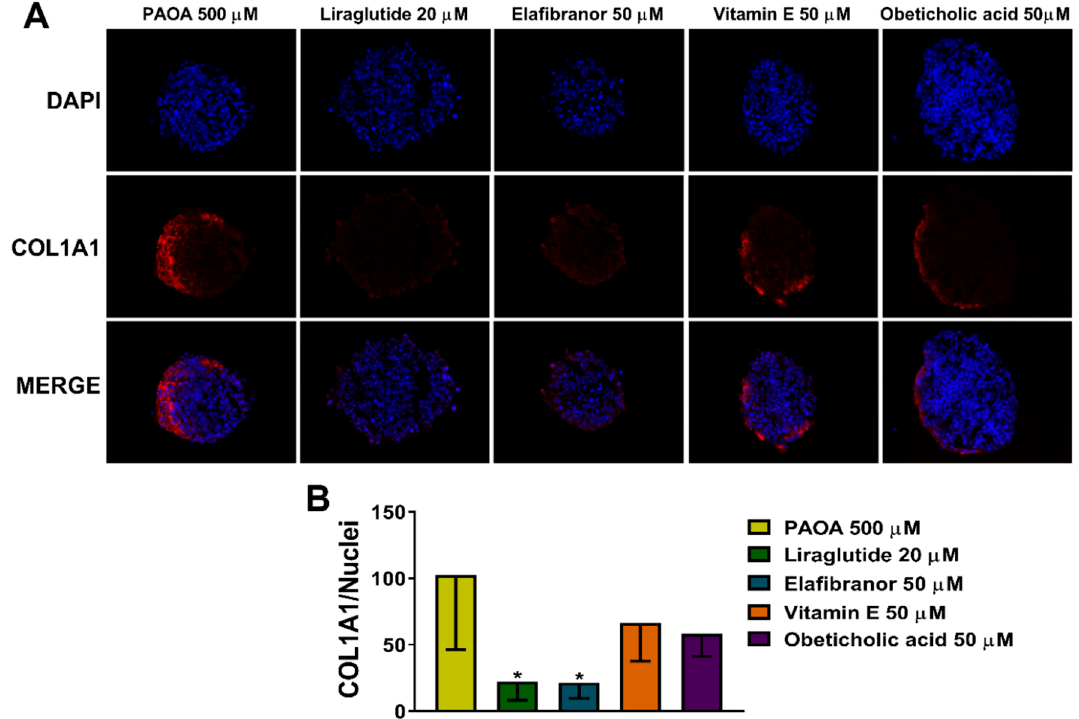
Figure 6. COL1A1 levels decrease in 3D multilineage spheroids treated with liraglutide or elafibranor. ( A ) Immunofluorescence staining of DAPI (blue), COL1A1 (red), and merged images of 3D spheroids (HepG2/LX-2, 24:1) treated, after 48 h from the seeding, with a mix of palmitic acid and oleic acid 500 µ M (1:2) bound to BSA 1%, with and without liraglutide 20 µ M, elafibranor 50 µ M, vitamin